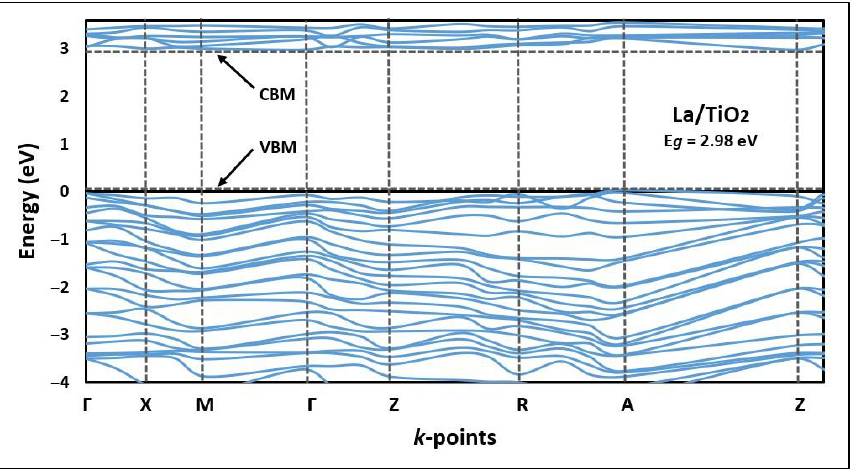
Figure 2. Band structure (BS) of La/TiO 2 along the high symmetry directions in the Brillouin zone.